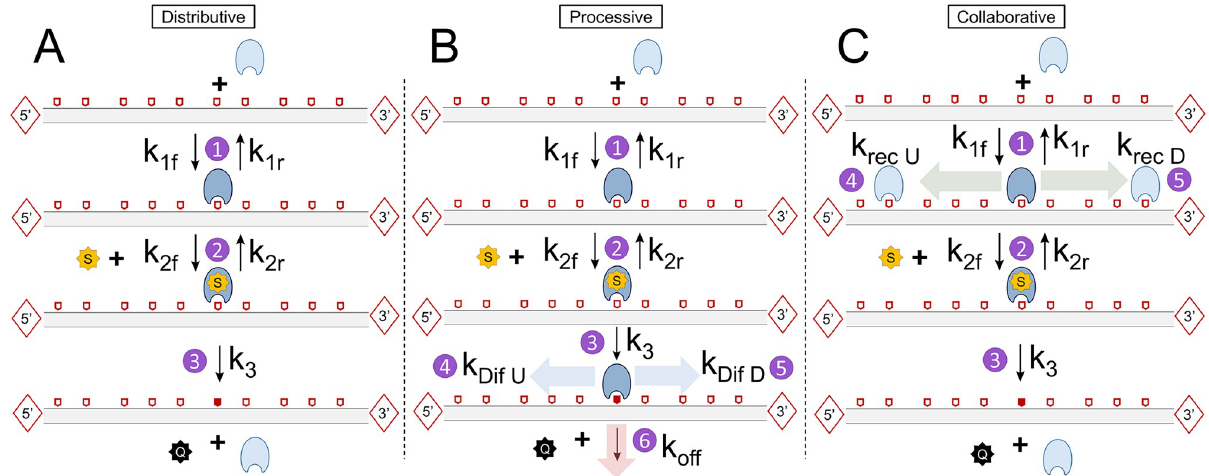
Fig 3. DNA remethylation Distributive (A), Processive (B) and Collaborative mechanisms (C). Hemimethylated sites (e.g. sites that can be remethylated) are indicated as empty pentagons, while methylated sites are represented as red-filled pentagons. Unmethylated sites are not represented in the scheme. In the Distributive model DNMT1 binds to a hemimethylated CpG site, incorporates SAM, and catalyzes methylation. Methylation and release of both DNMT1 and SAH occur in a single step. In the Processive model, after methylation DNMT1 can diffuse towards its immediate neighbor sites either upstream (U) or downstream (D). In the Collaborative model, once DNMT1 is bound to a hemimethylated CpG, a second DNMT1 molecule can be recruited onto nearby CpG sites. A distance function adapted from [42] favors recruitment at nearer CpGs.